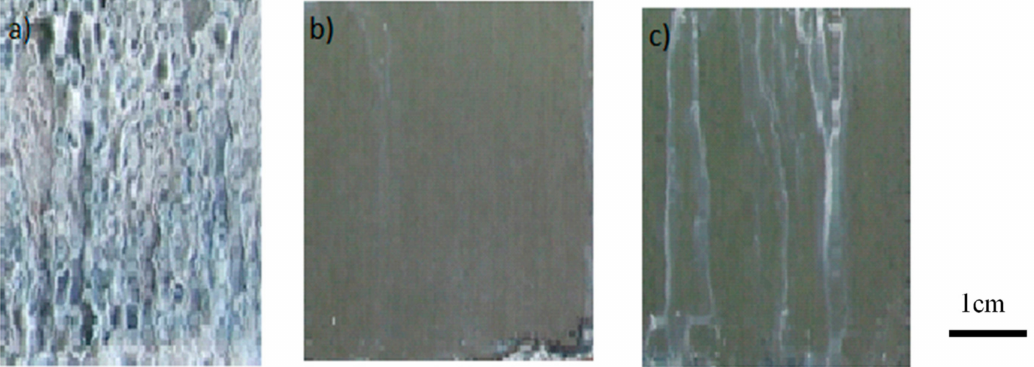
Figure 12. Salt spray test performed for 240 h on ( a ) phosphated zinc; ( b ) phosphated zinc + TEOS/